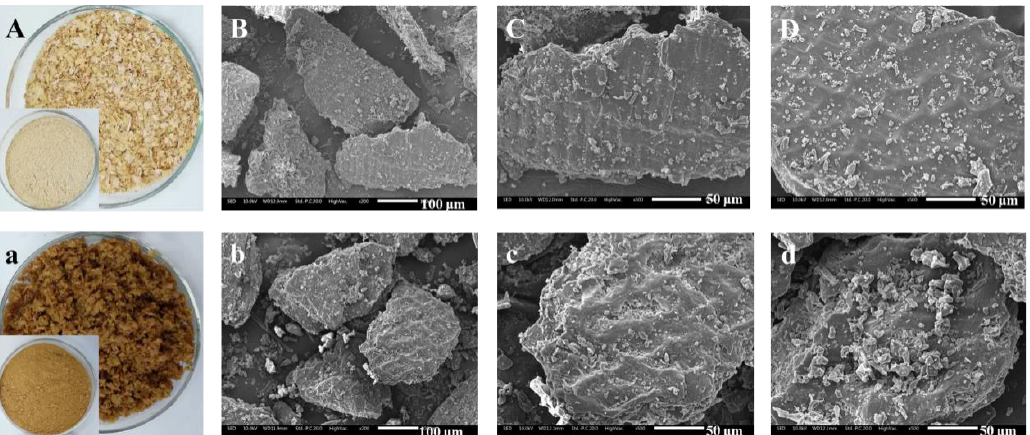
Figure 5. Photographs and SEM micrographs of raw bran and SE bran. ( A , a ): photographs of raw bran and SE bran; ( B – D ): SEM micrographs of raw bran powders through a 60 mesh screen ( B ): 200×; ( C , D ): 500×); ( b – d ): SEM micrographs of SE bran powders through a 60 mesh screen ( b ): 200×; ( c , d ): 500×).